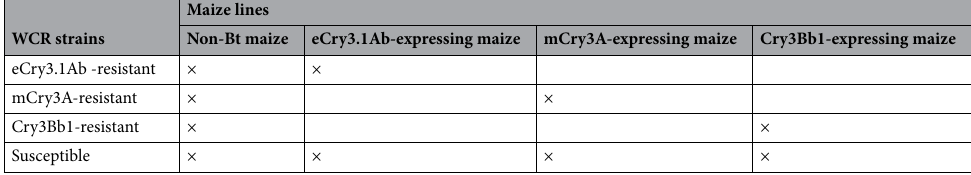
Table 1. Experimental design used to rear resistant and susceptible western corn rootworm larval strains on three Bt-expressing maize lines and one control maize line without Bt.